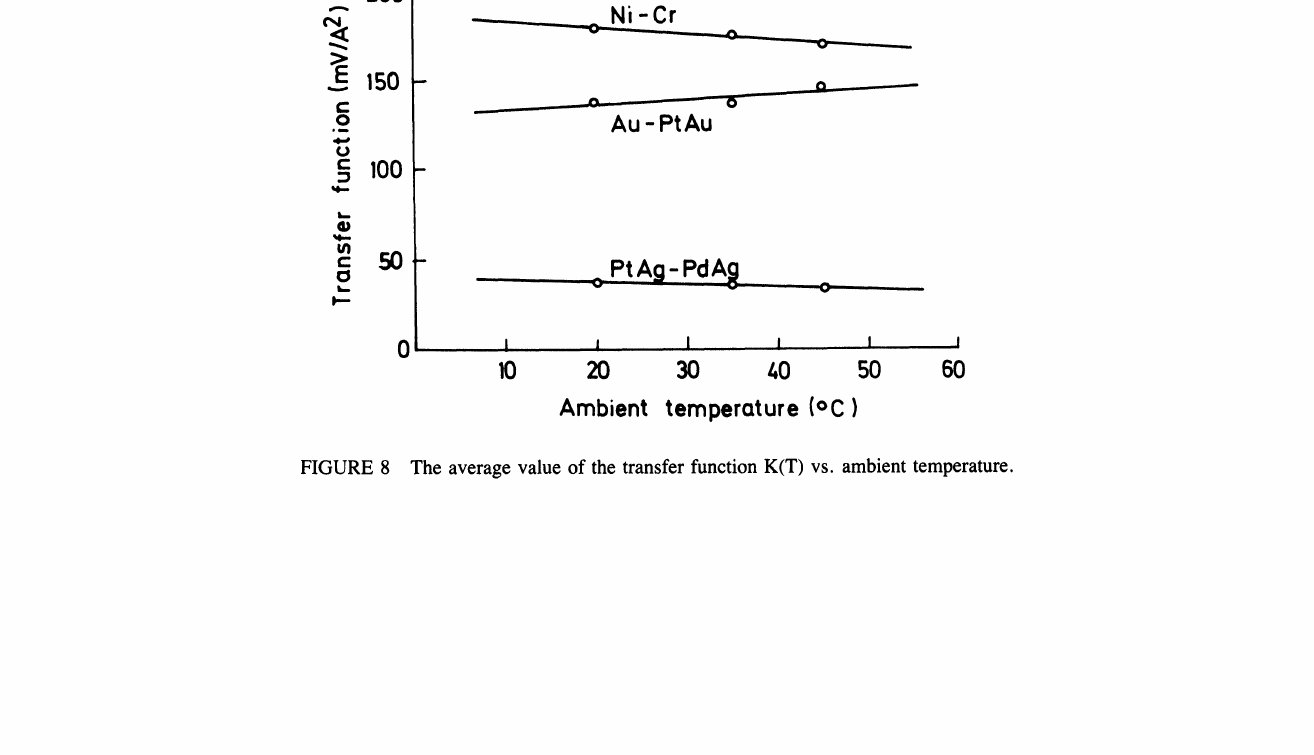
FIGURE 8 The average value of the transfer function K(T) vs. ambient